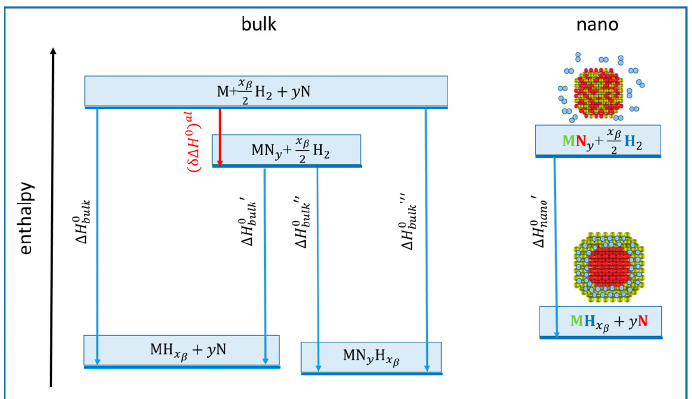
Figure 5. Schematic representation of thermodynamic tuning of reaction (1) (enthalpy ∆H (cid:3029)(cid:3048)(cid:3039)(cid:3038)(cid:2868) ) by addition of an element N that can: (i) form an alloy in the α -phase (reaction (13), enthalpy ∆H (cid:3029)(cid:3048)(cid:3039)(cid:3038)(cid:2868) ′ ); (ii) form an alloy in the α -phase and a ternary hydride (reaction (14), enthalpy ∆H (cid:3029)(cid:3048)(cid:3039)(cid:3038)(cid:2868) ′′ ), or (iii) form a ternary hydride (reaction (15), enthalpy ∆H (cid:3029)(cid:3048)(cid:3039)(cid:3038)(cid:2868) ′′′ ). The enthalpy of reaction (13) in nanomaterials can be further tuned by different elemental distributions in the α - and β -phases. The example on the right shows the case of a metallic random alloy NP that transforms into a metal-metal hydride core-shell structure upon hydrogen